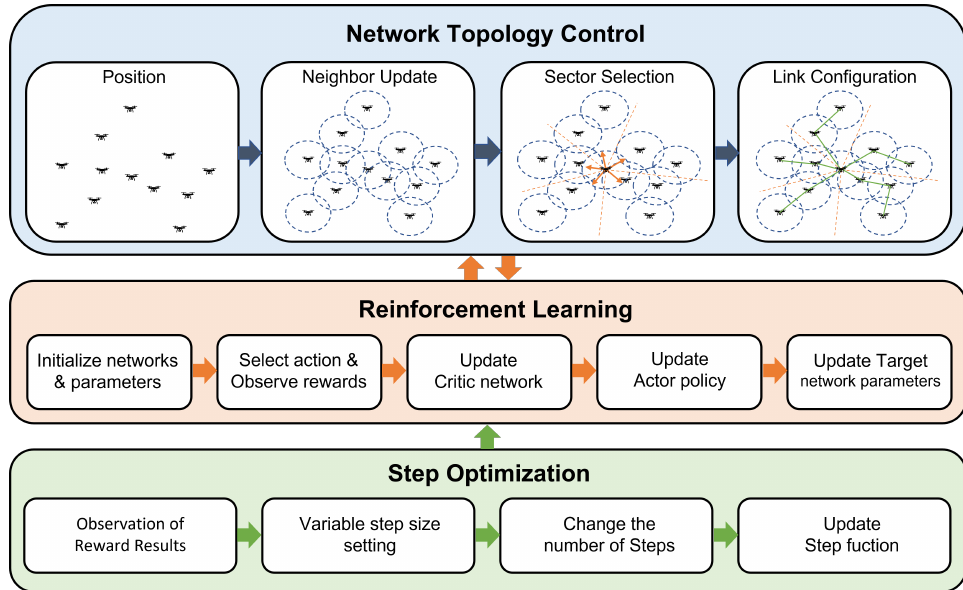
Figure 2. The overall oprations of proposed